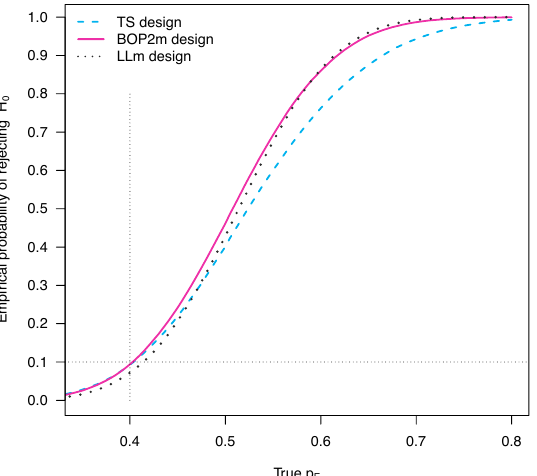
Figure 4. Behavior of the empirical probability of rejecting H 0 for different values of the true p E , when N = 40, N min = 10, δ = 0.1, π ( p S ) = beta ( p S ;63,94 ) , and π ( p E ) = beta ( p E ;1.4,1.6 ) . The stopping boundaries used are provided in Sections 3.1, 3.2.1 and 4.1.1 for the TS, the BOP2m and the LLm designs,